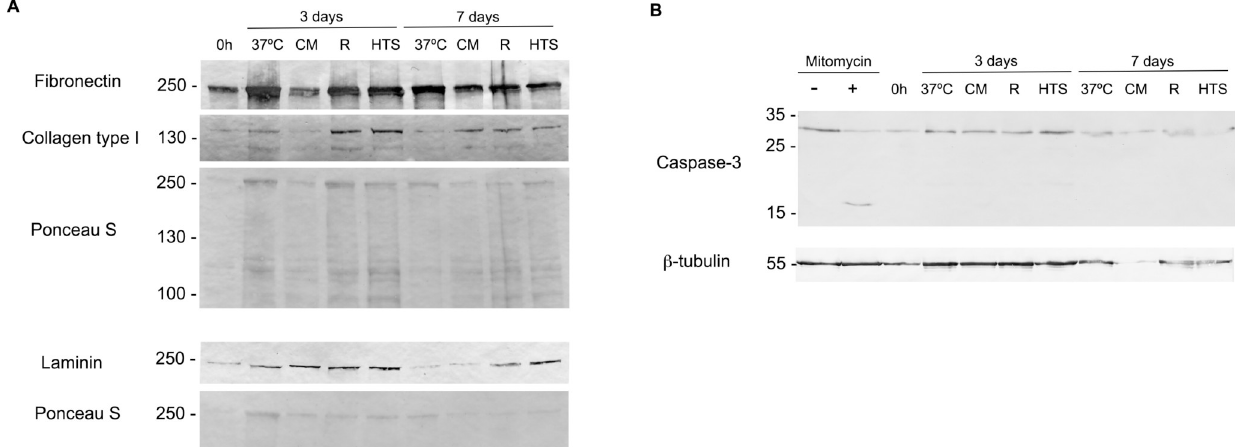
Fig 5. Western blot analysis of extracellular matrix and caspase 3 proteins. Western blot analysis of confluent hASCs preserved at 4˚C, in the presence and absence (Culture medium) of hypothermic storage solutions for 3 and 7 days. A control culture at 37˚C was also performed. The expression of extracellular matrix proteins fibronectin, type I collagen and laminin, as well as, caspase 3 activation expression was assessed. Samples were collected after cultures being subjected to a respective recovery period of 24 hours. For extracellular matrix proteins 15 μ l of each sample were loaded, whereas for caspase 3, 30 μ g were analyzed. Negative and positive controls for apoptosis, without and with mitomycin respectively, were also included to assess caspase activation. A) Ponceau S and B) β -Tubulin are shown as loading controls for fibronectin, type I collagen and laminin expression and caspase 3 activation,